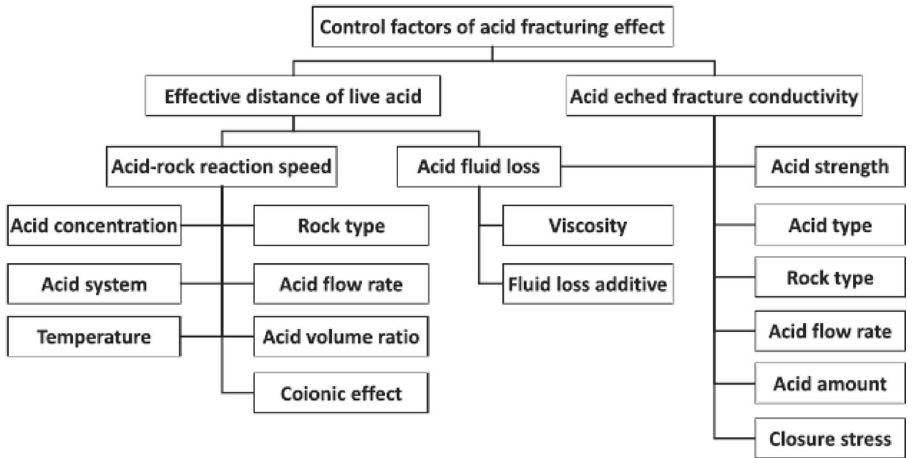
Fig. 1 Considerable influence of factors on the acid fracturing (Li et al.